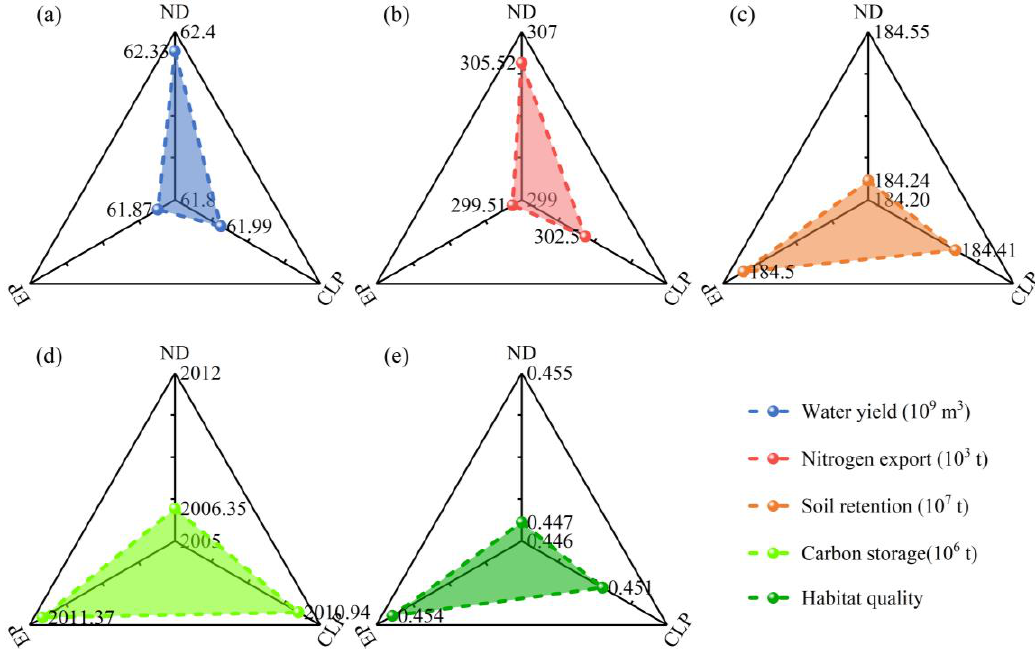
Figure 10. Changes in ESs in 2030 under different scenarios.